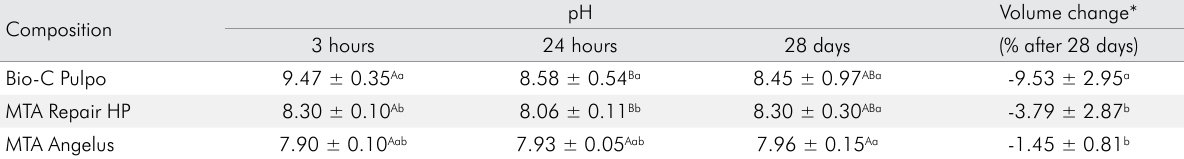
Table 3. Representation of mean and standard deviation values of pH and volume